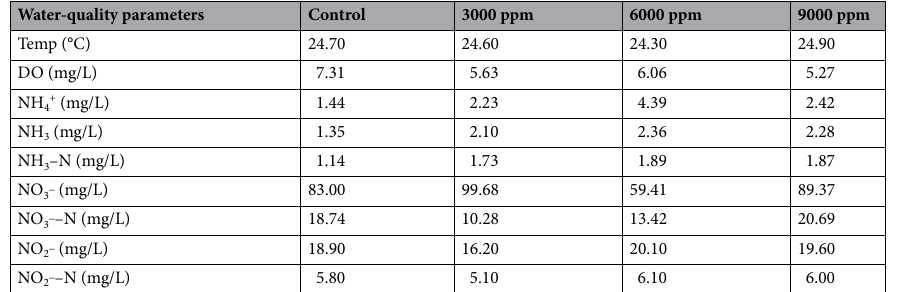
Table 3. Average water quality values of freshwater and saline water used for rearing Nile tilapia ( Oreochromis niloticus ) during the study period . Water quality parameters, Temp temperature, DO dissolved oxygen, NH 4 +